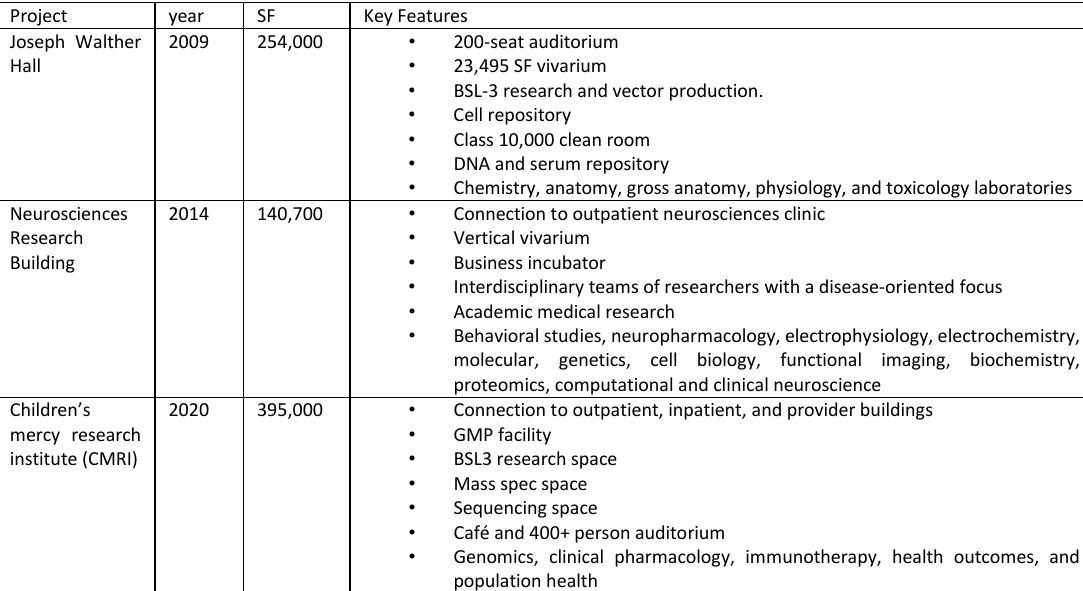
Figure 1 An overview of the project timelines (Image copyright: Author). Table 1 Key Characteristics of the three Science and Technology